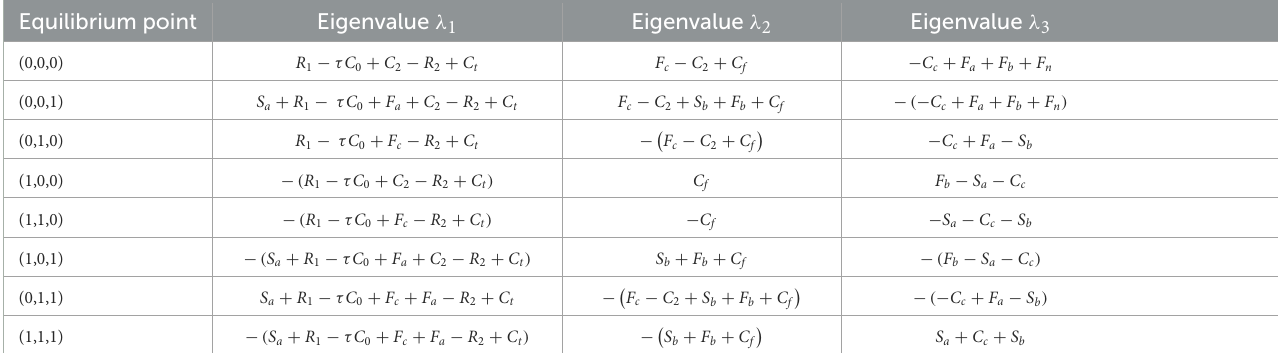
TABLE 2 Jacobian matrix